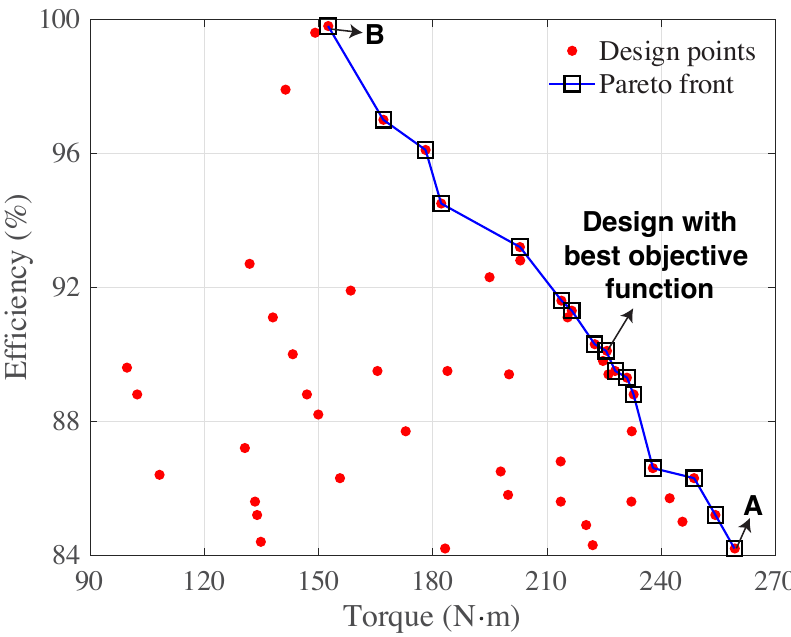
Figure 8. Scatter plot of efficiency vs. torque for all the cases showing the Pareto optimal